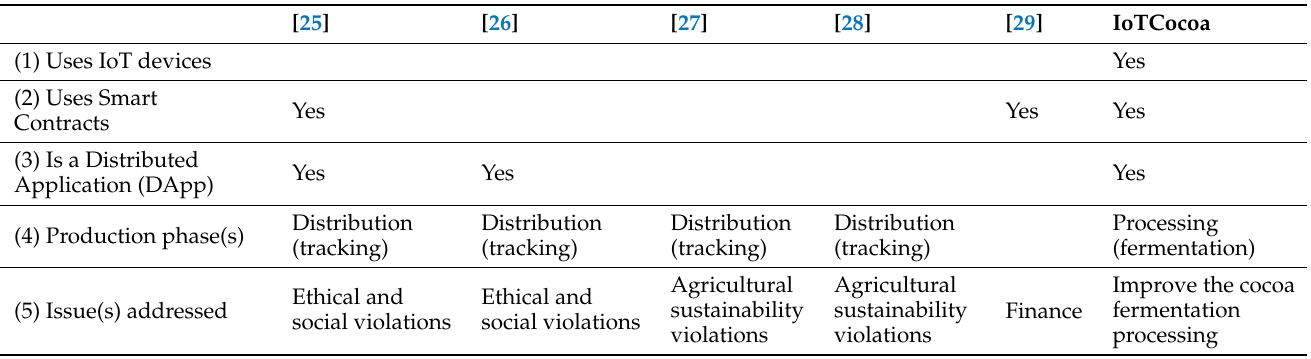
Table 2. Comparison between IoTCocoa and other cocoa blockchain-based